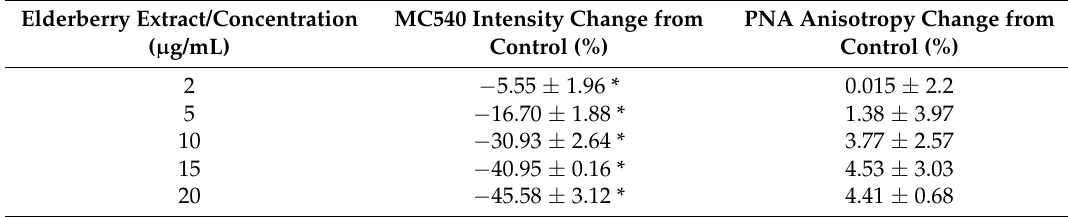
Table 2. Changes in fluorescence intensity (for MC540 probe) and fluorescence anisotropy (for PNA probe) in the presence of elderberry extract in lipid mimic